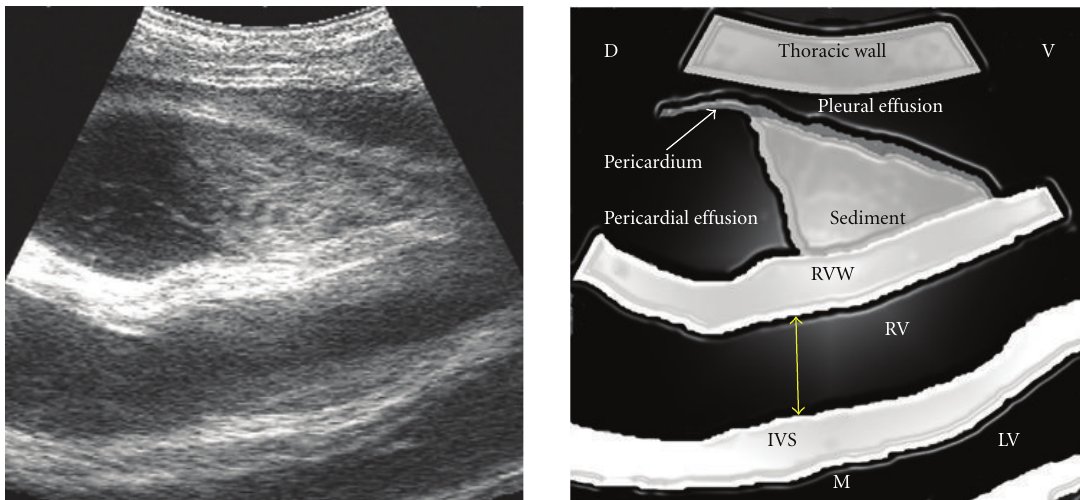
Figure 5: Two-dimensional echocardiogram obtained after ultrasound-guided aspiration of the pericardial e ff usion from the right 4th ICS, by placing the transducer parallel to the ribs. Notice the increase in the size of the right